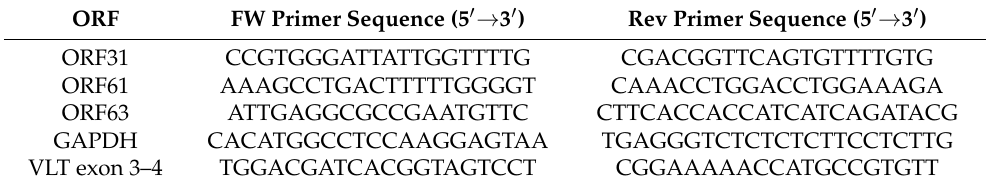
Table 2. Primers used for detecting transcripts in VZV-infected cells by qRT-PCR.